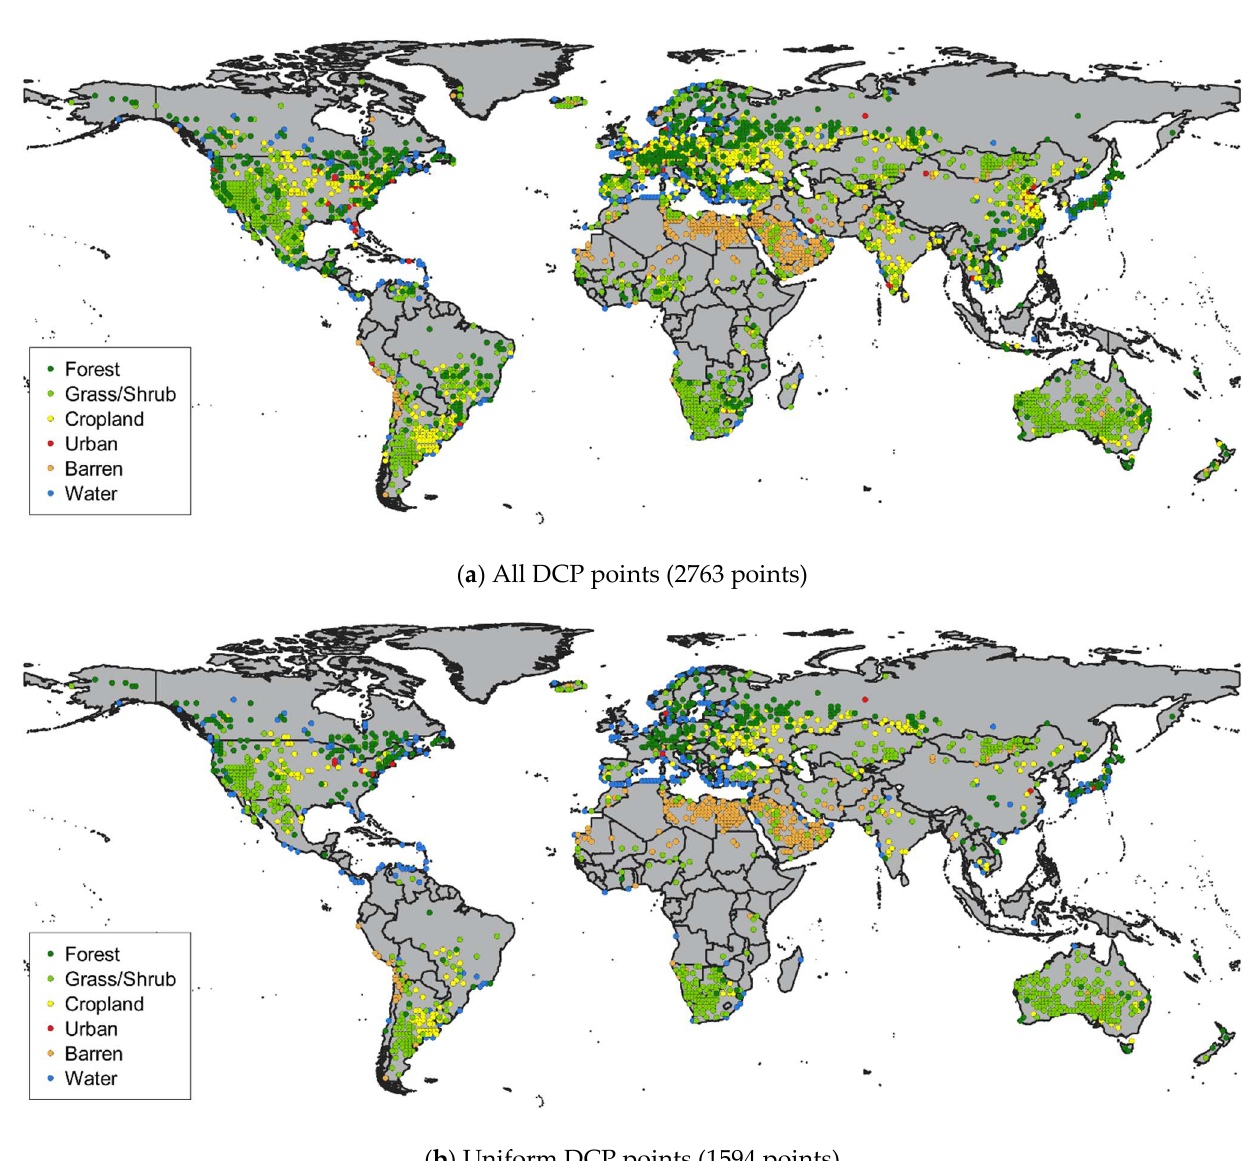
Figure 4. Distribution of ( a ) all DCP points and ( b ) DCP points with guaranteed uniformity at the 300 m scale.